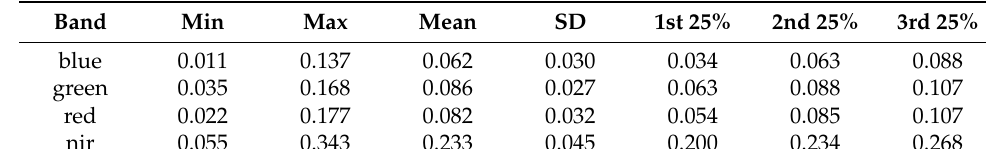
Table 2. Surface reflectance in the four bands.